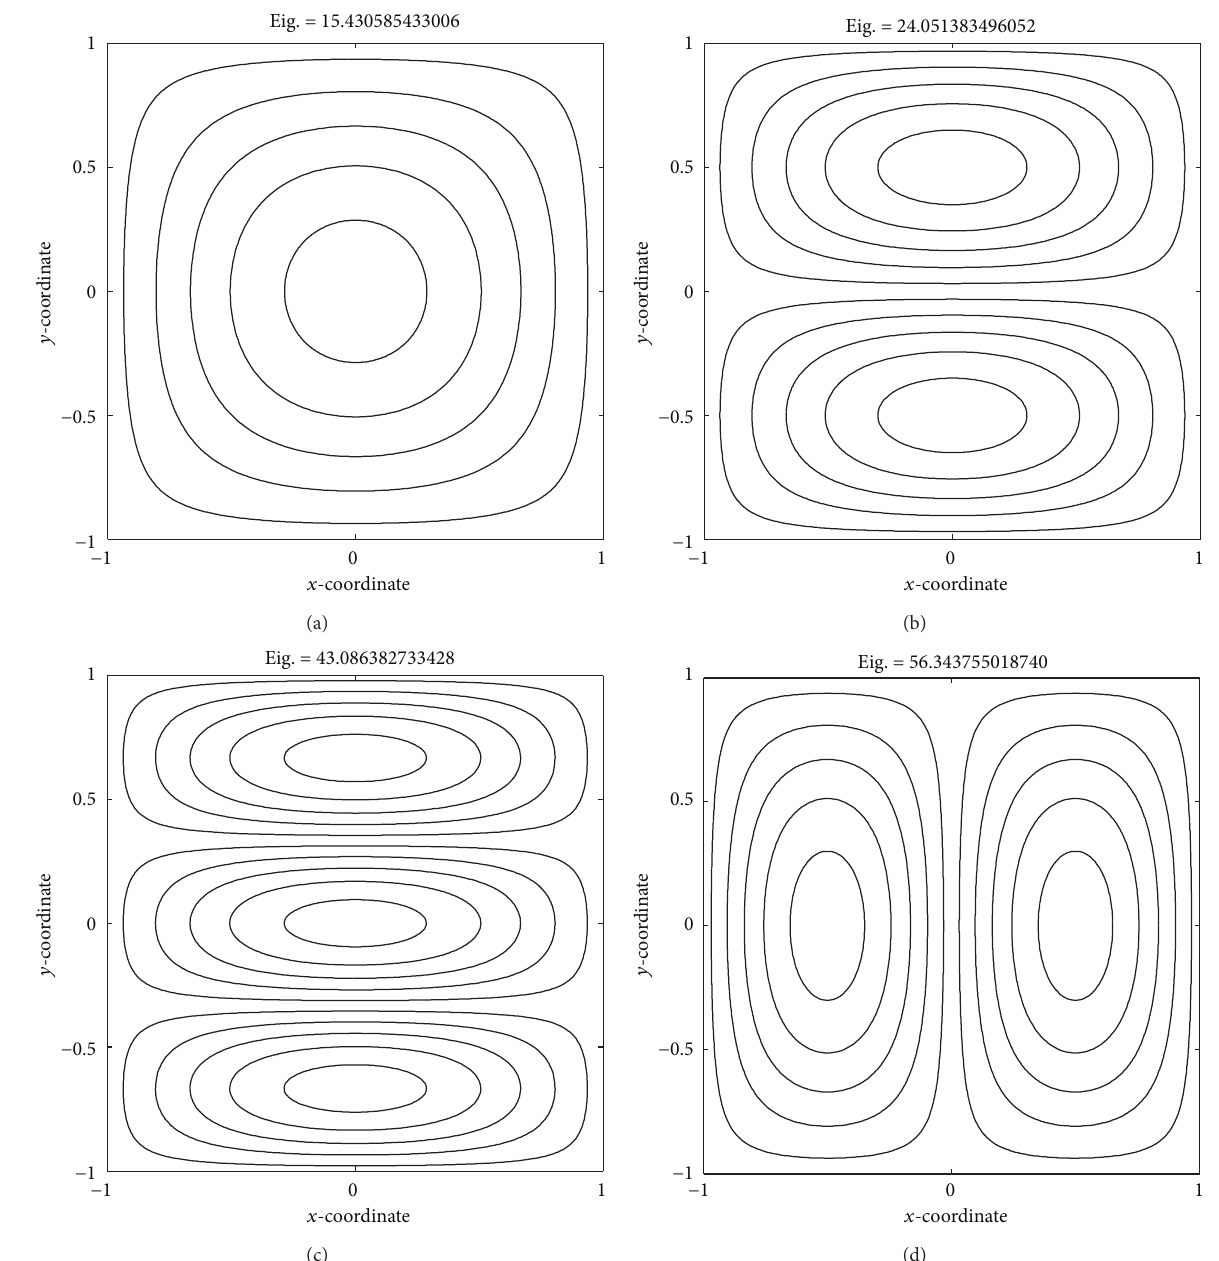
Figure 5: The first 4 vibrational modes of cross-ply laminated spherical shells, 𝜔 = 𝜔(𝑎 2 /ℎ)√𝜌/𝐸 2 , for laminate ( [0 ∘ /90 ∘ /0 ∘ ] ) using a grid of 21 × 21 points, for 𝑎/ℎ = 100 , 𝑅/𝑎 = 10𝑒 9